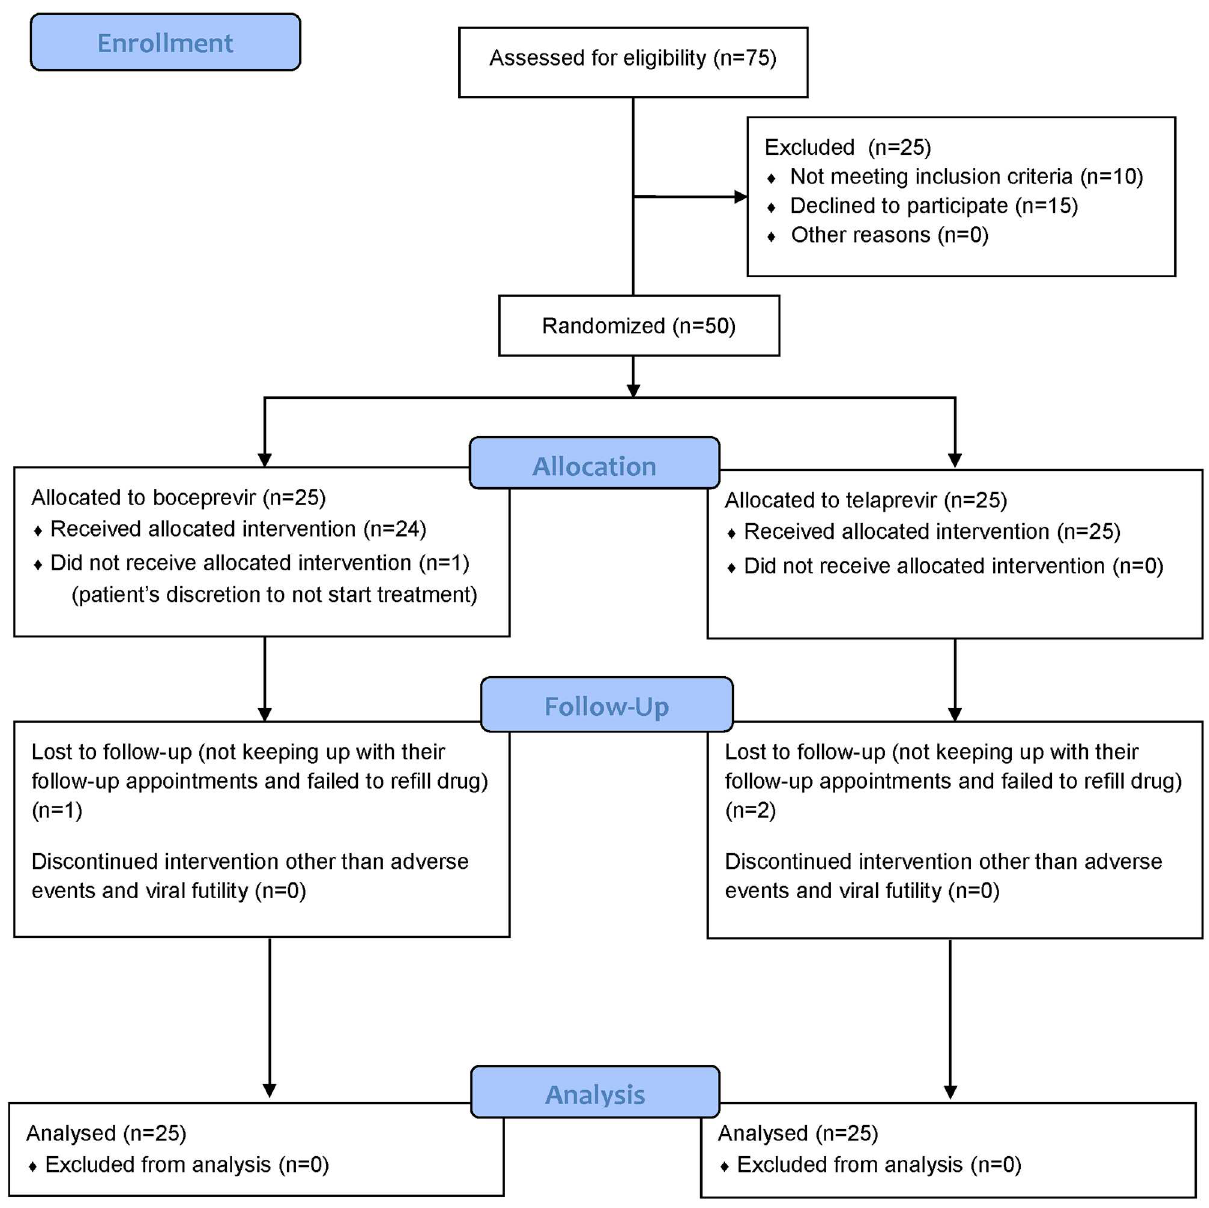
Fig 1. CONSORT Flow